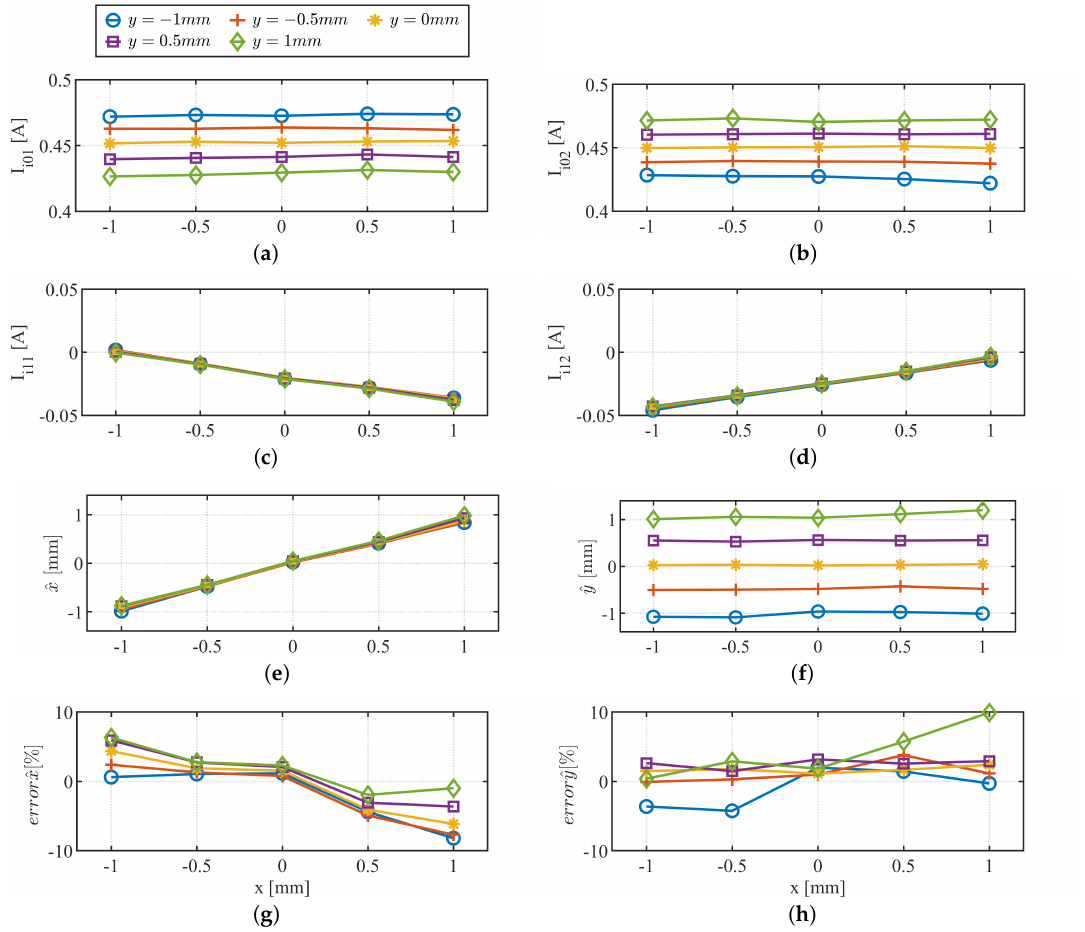
Figure 14. Experimental results varying x from − 1 mm to +1 mm in steps of 0.5 mm at constant y position. ( a ) I i 01 ; ( b ) I i 02 ; ( c ) I i 11 ; ( d ) I i 12 ; ( e ) ˆ x ; ( f ) ˆ y ; ( g ) error ˆ x ; ( h ) error ˆ y